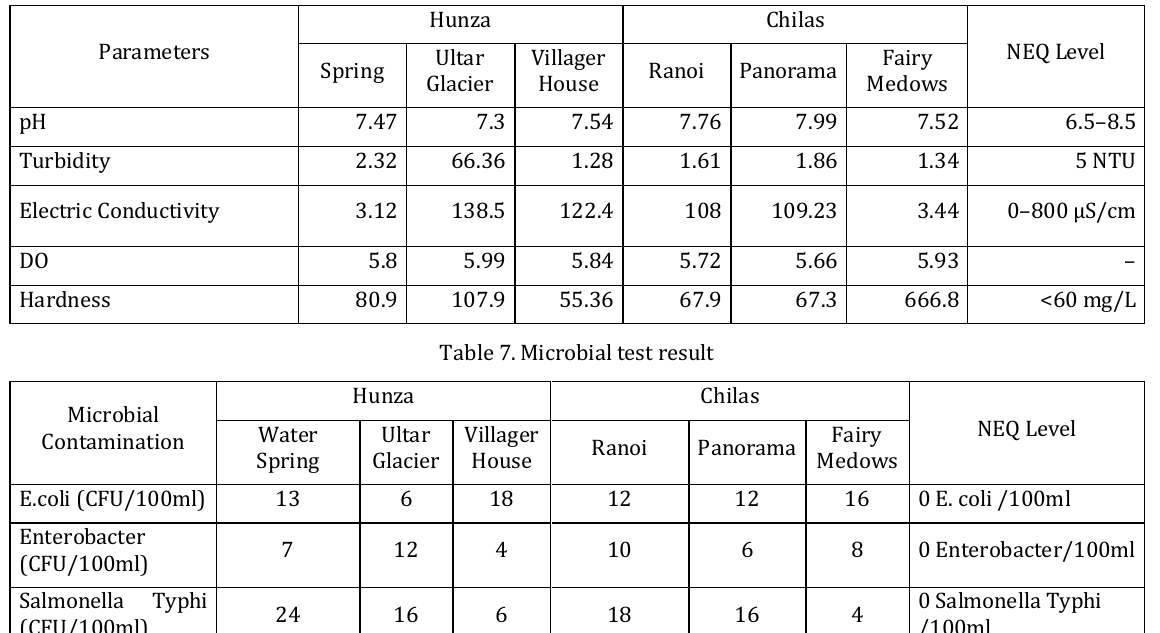
Table 6. Physicochemical test result